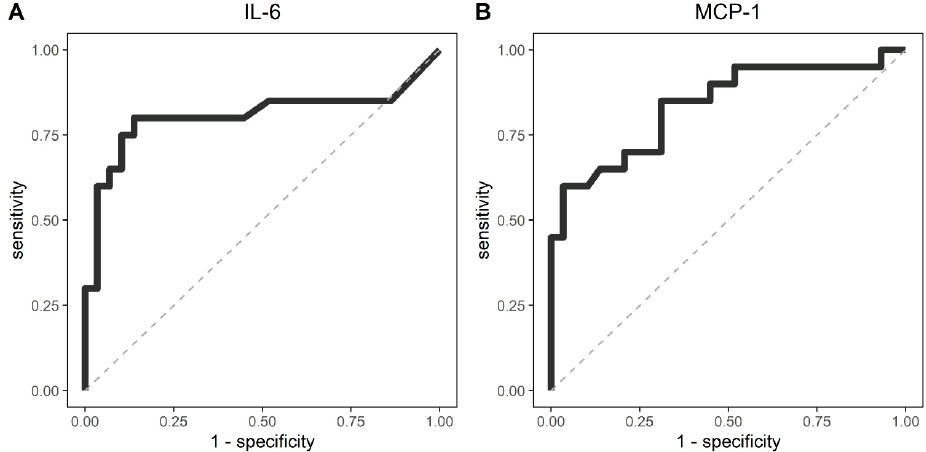
Figure 5. ROC analyses of cytokines and chemokines to discriminate severe cases. ( A ) ROC curve for IL-6, AUC = 0.805 (95% CI 0.652–0.958) and optimal cut-off 4.2 pg/mL (sensitivity: 80%, specificity: 86%); ( B ) ROC curve for CCL2/MCP-1, AUC = 0.837 (95% CI 0.716–0.958) and optimal cut-off was 547.8 pg/mL (sensitivity: 60%, specificity: 96%).